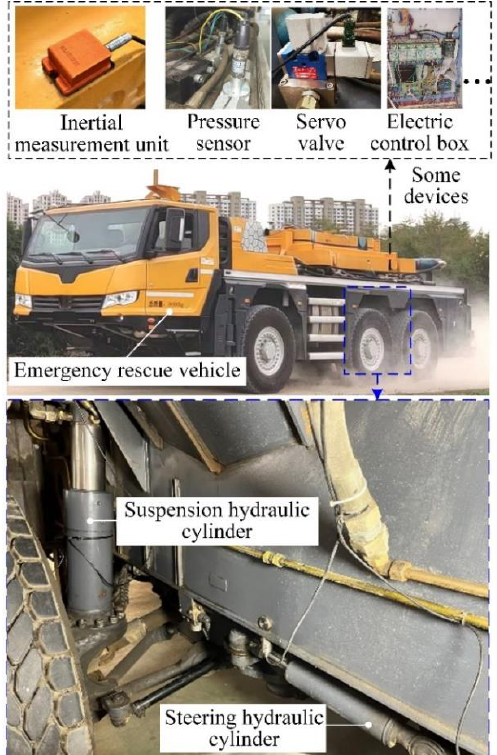
Figure 8. Emergency rescue vehicle. Table 6. Main parameters of emergency rescue vehicles.